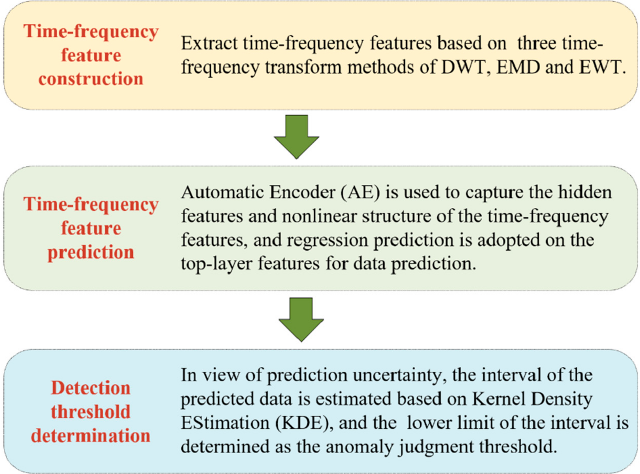
Figure 1. Technical framework of the